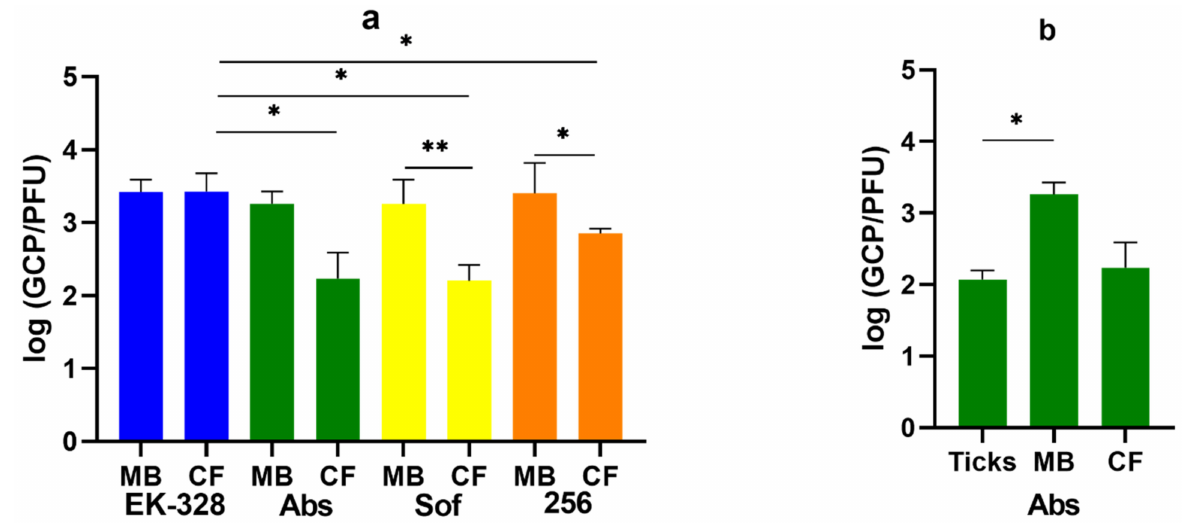
Figure 7. The values of log (GCP/PFU) for the virus samples of four TBEV strains: EK-328 (blue), Absettarov (Abs, green), Sofjin (Sof, yellow) and 256 (orange) after the reproduction ( a ) in PEK cell culture (CF) and in ICR suckling mouse brains (MB) after i/c inoculation. ( b ) GCP/PFU ratio of Absettarov TBEV strain after 7 days in Ixodes ricinus ticks. The experiment was carried out in 3–5 biological replicates. Error bars indicate SD. * p < 0.05; ** p < 0.01 obtained by Mann-Whitney